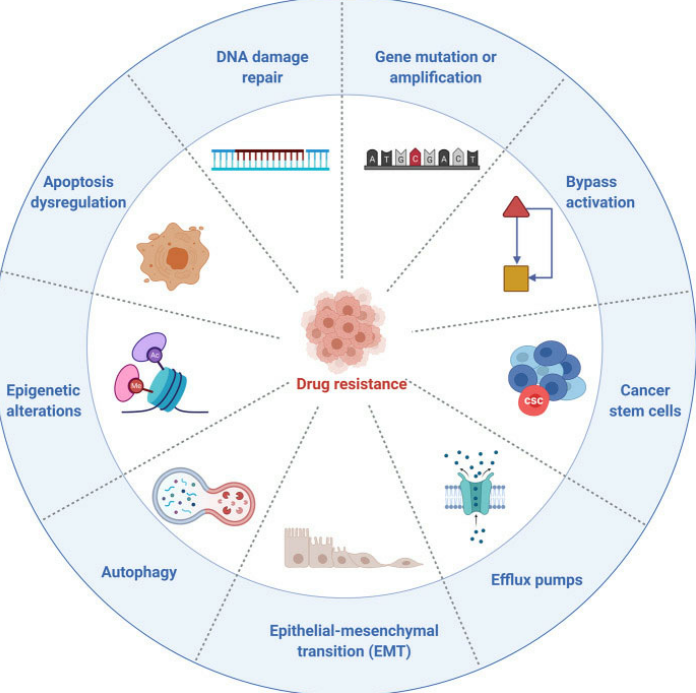
Figure 5. Mechanisms in drug resistance of targeted anticancer agents. Reprinted with permission from Ref. [161]. 2021, Springer.